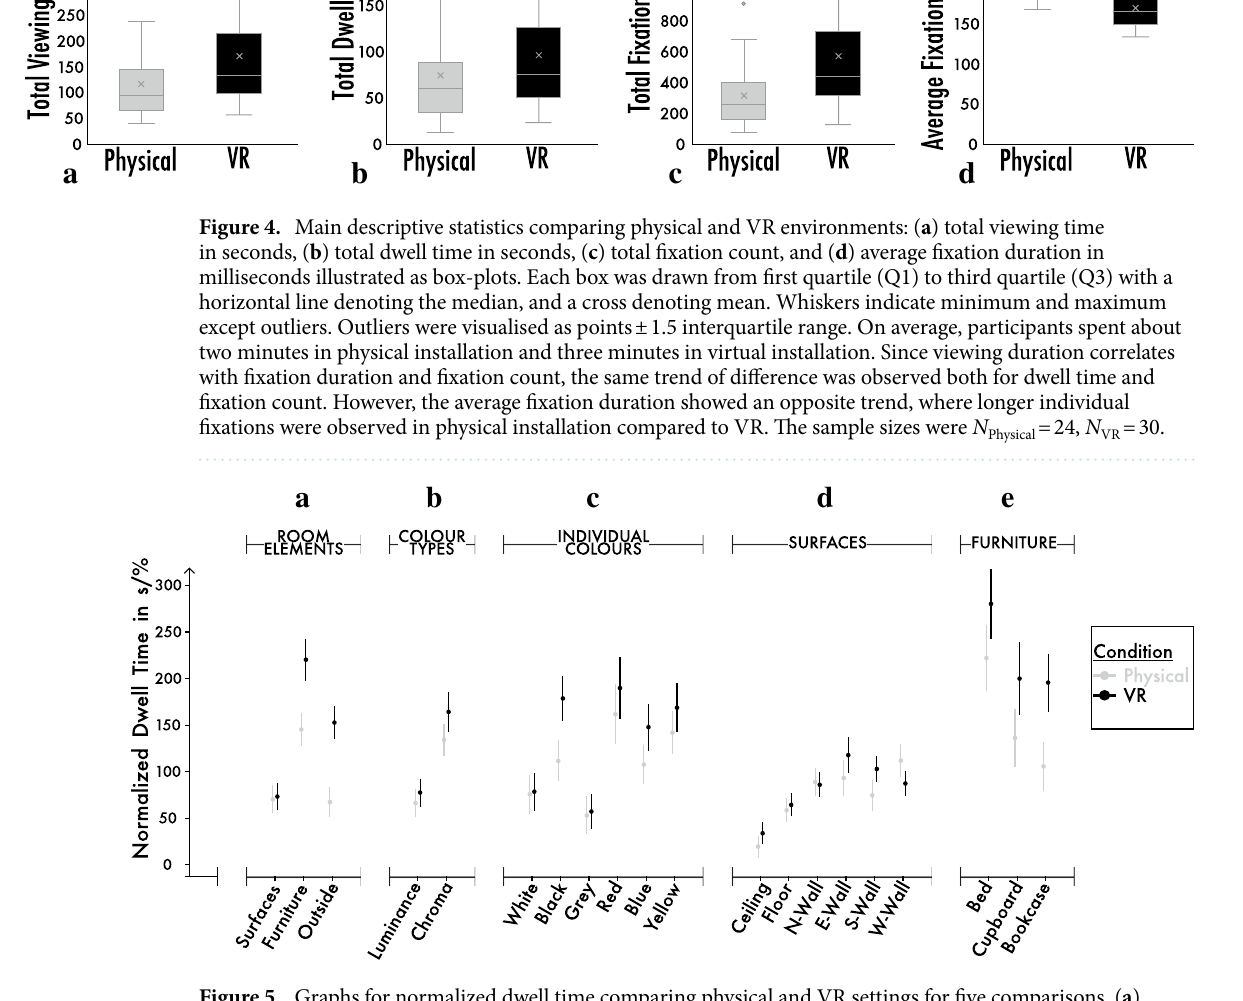
Figure 5. Graphs for normalized dwell time comparing physical and VR settings for five comparisons. ( a ) Room elements, ( b ) colour types, ( c ) individual colours, ( d ) surfaces, and ( e ) furniture. The x-axis shows the levels of AOIs, and the y-axis shows absolute dwell time in seconds. Physical and VR conditions were colour- coded as grey and black, respectively. The visualized data based on means, with whiskers indicating standard errors. The sample sizes were N Physical = 24, N VR =